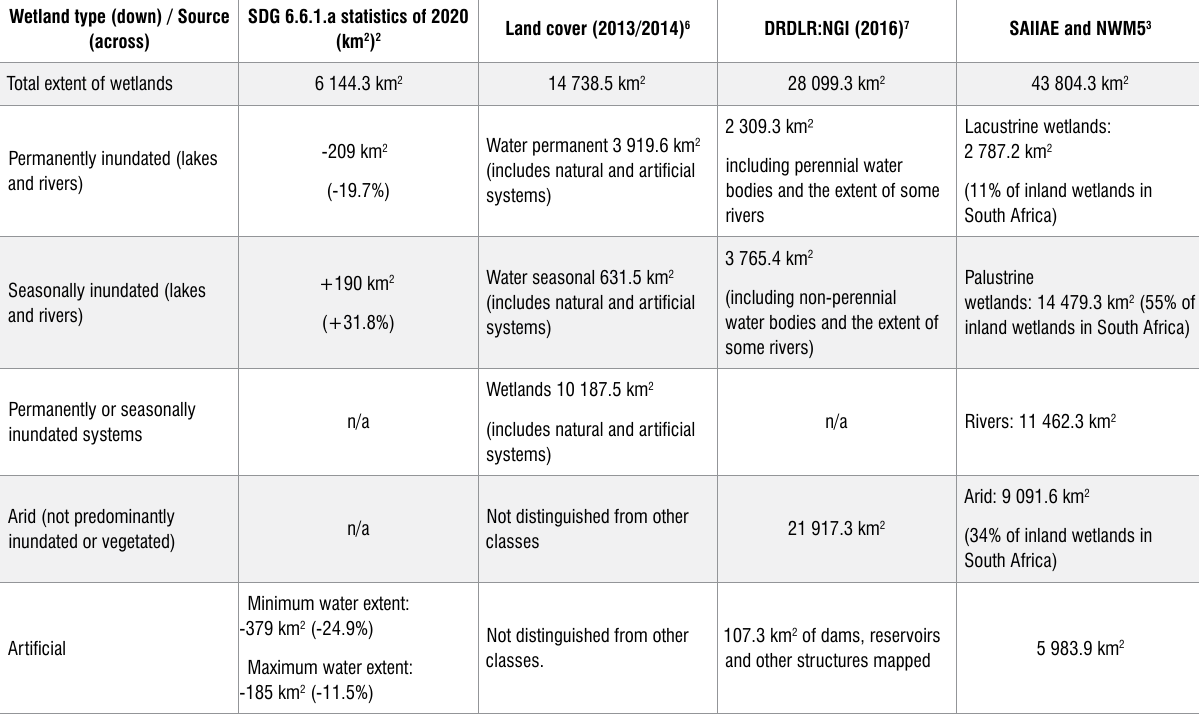
Descriptive statistics related to the spatial extent of surface wetland types available on the Freshwater Ecosystems Explorer for reporting on Sustainable Development Goal sub-indicator 6.6.1.a, in comparison to three South African data sets Wetland type (down) / Source (across)